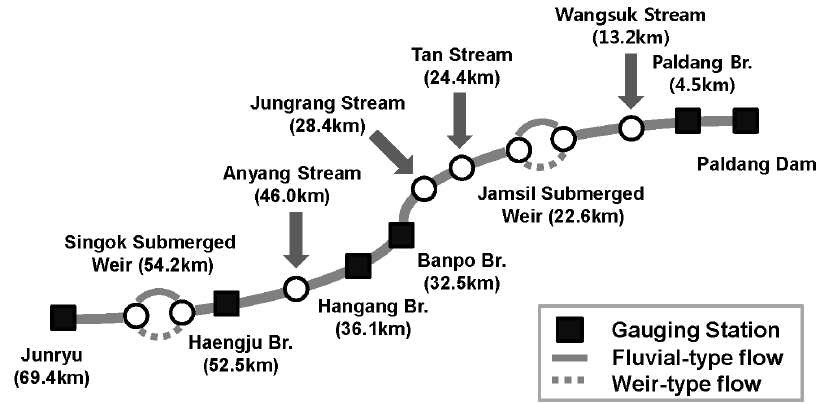
Figure 2. Schematic representation of the modeled river reach [30].